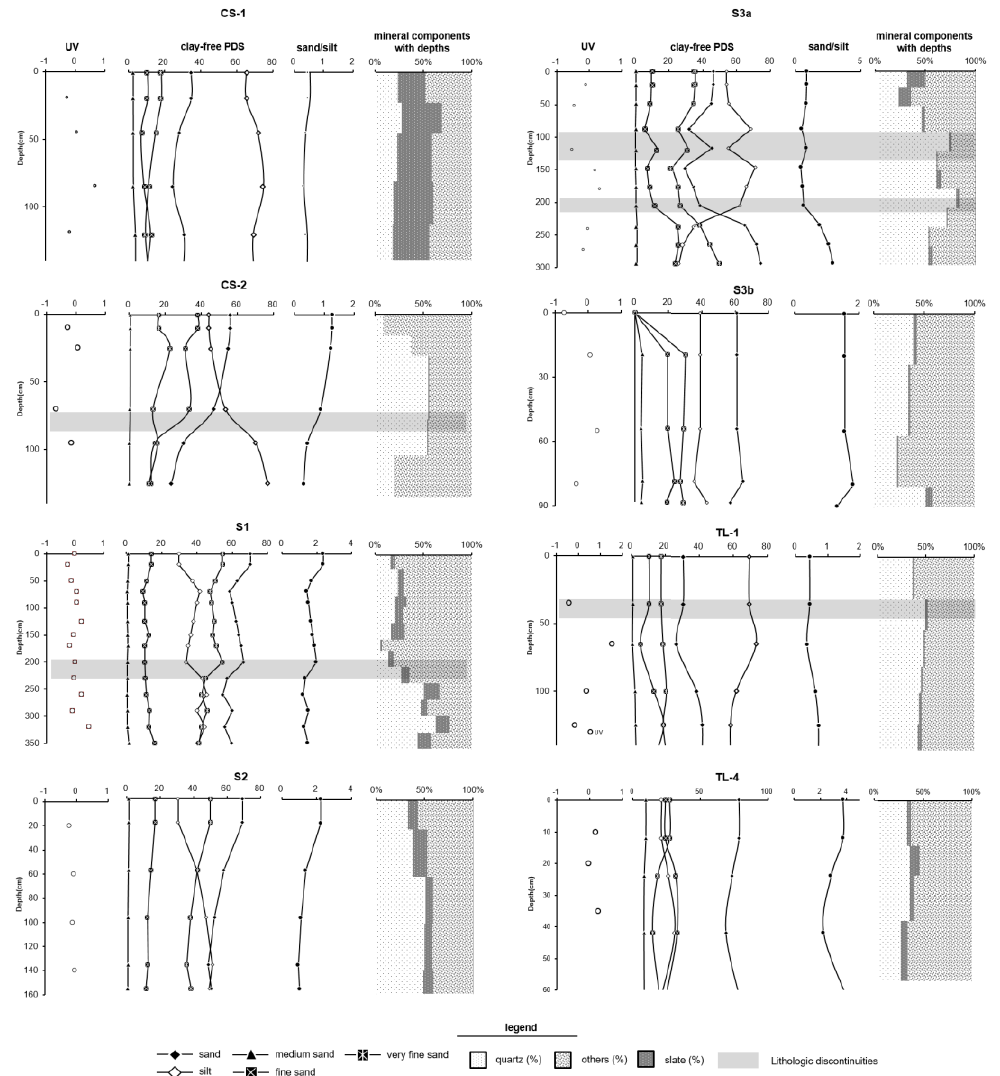
Figure 5. Depth distributions of UV value, clay-free PDs, sand/silt ratio, and three groups of rock fragments in sand-size fractions for the eight soils in the study. Parameters of CS − 1, CS − 2, TL − 1, and TL − 4 soil were calculated and determined based on the data proposed by Tsai et al. [23]. CS − 1, S2, S3b, and TL-4 had no LDs, whereas one or two LDs were identified in CS-2, S1, S3a, and TL-1. Mineral components showed that slates were present in all soils in varying amounts. It suggested that parent materials of all soils originated from sediments of the Zoushui River and its tributaries.